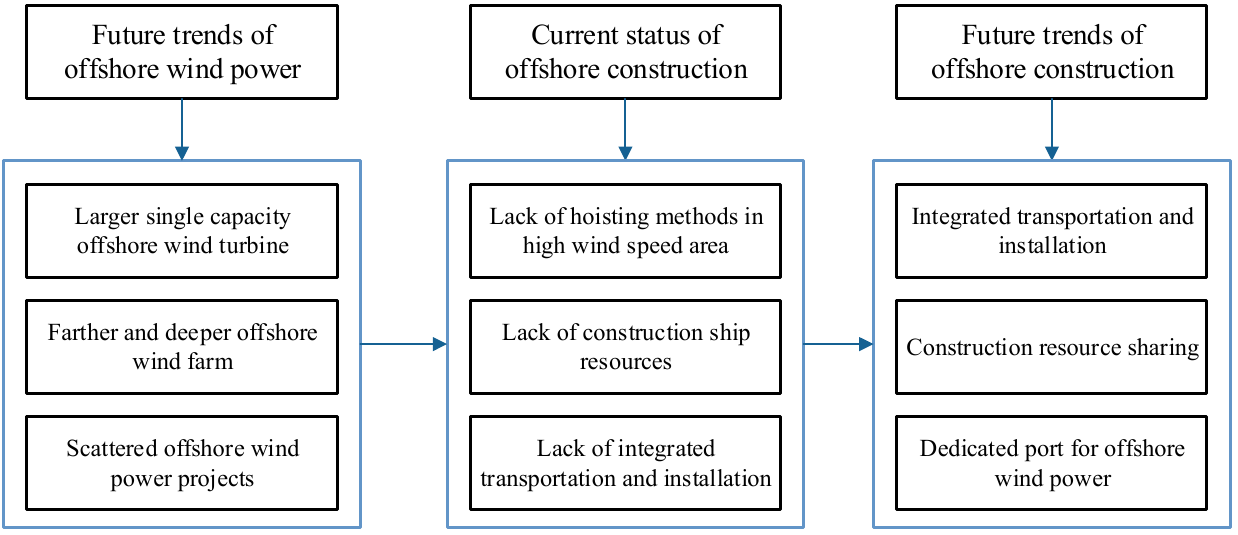
Figure 8. Development trend of offshore wind farm construction.